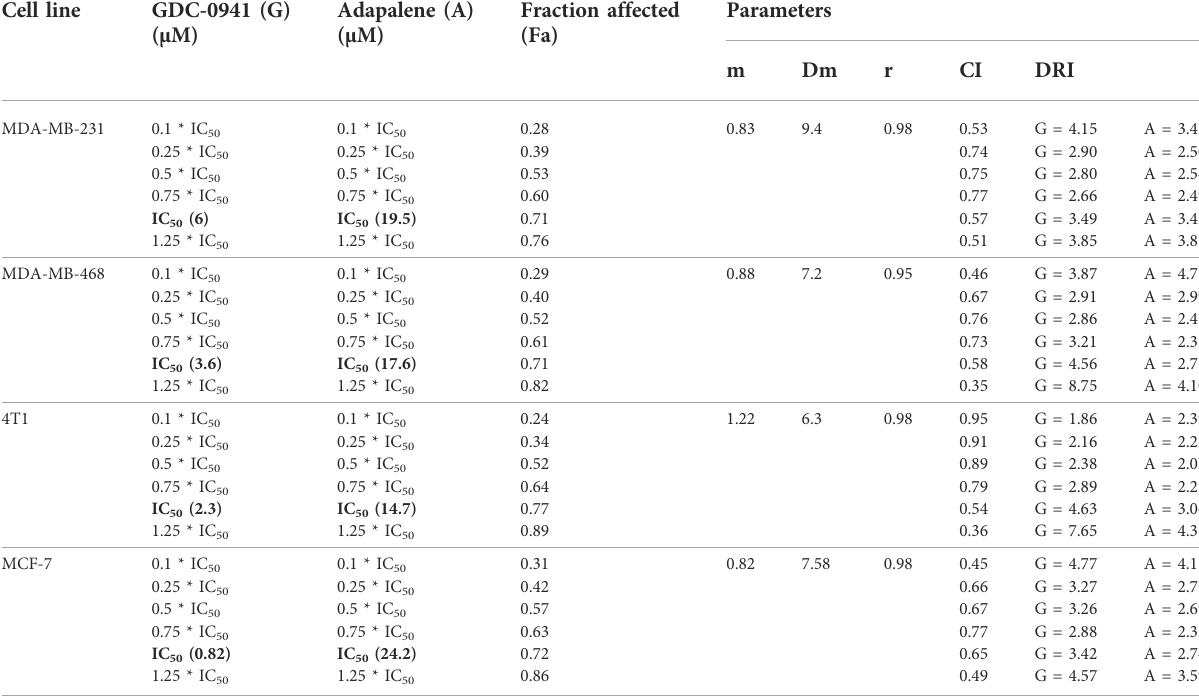
TABLE 1 Experimental design and data summary of the dose – effect curve and Chou – Talalay parameters of GDC-0941 and adapalene drug combinations against breast cancer cell lines after 72 h treatment period. Cell